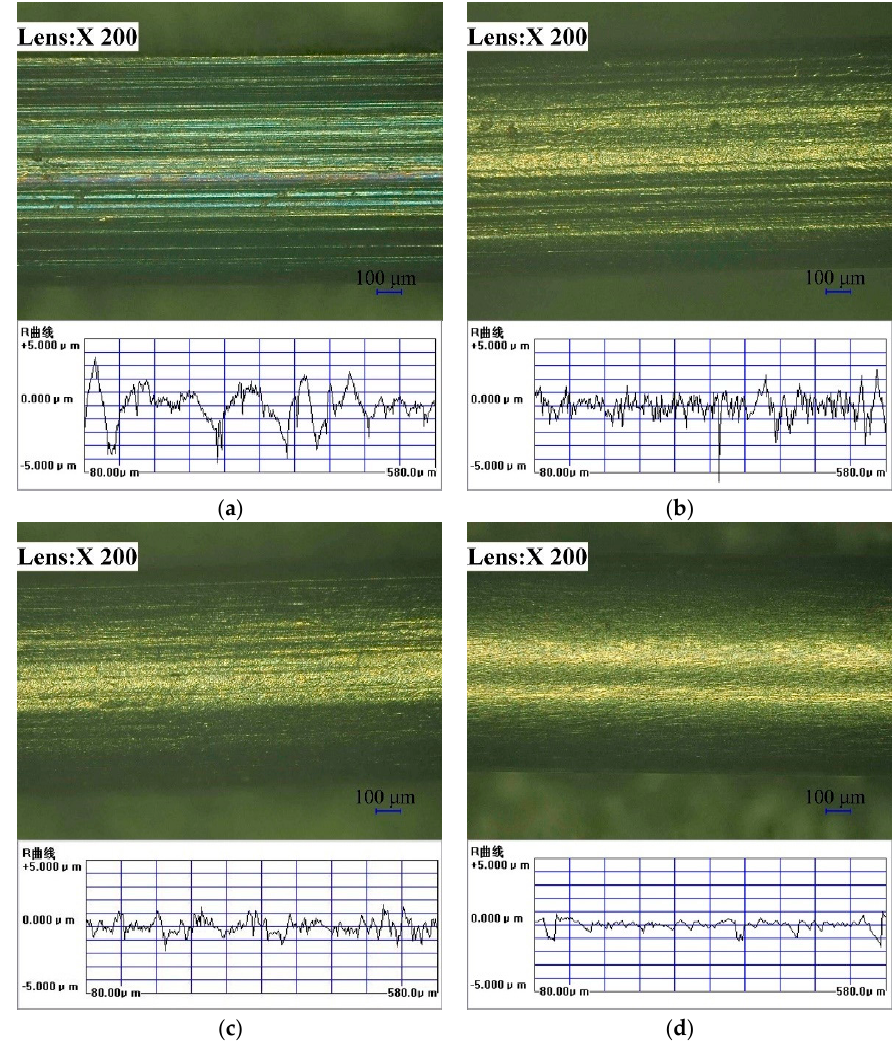
Figure 4. Superfield electron microscopic images of the surface of the titanium alloy wire workpiece before and after magnetic abrasive finishing: ( a ) Before finishing (Ra: 0.92 μ m); ( b ) After finishing (Ra: 0.63 μ m, magnetic head taper: 0°); ( c ) After finishing (Ra: 0.48 μ m, magnetic head taper: 25°); ( d ) After